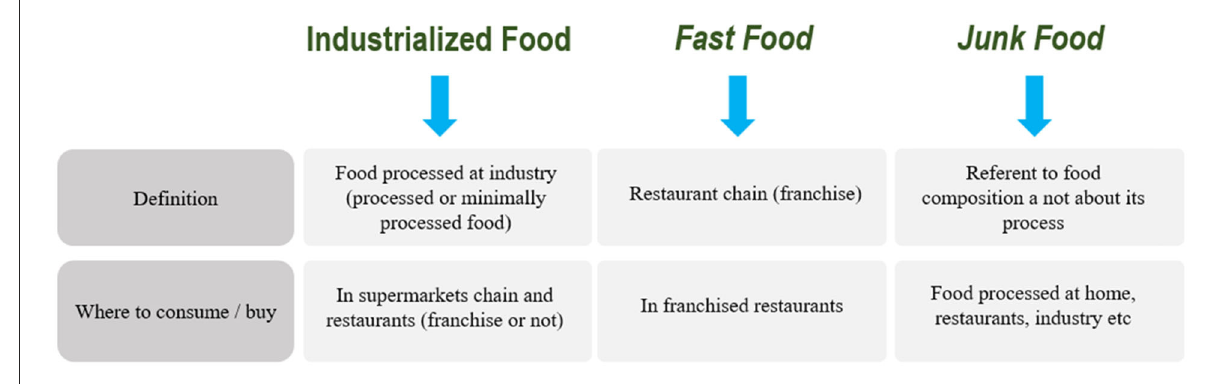
FIGURE2 Fast food, junk food, and industrialized food—definitions and